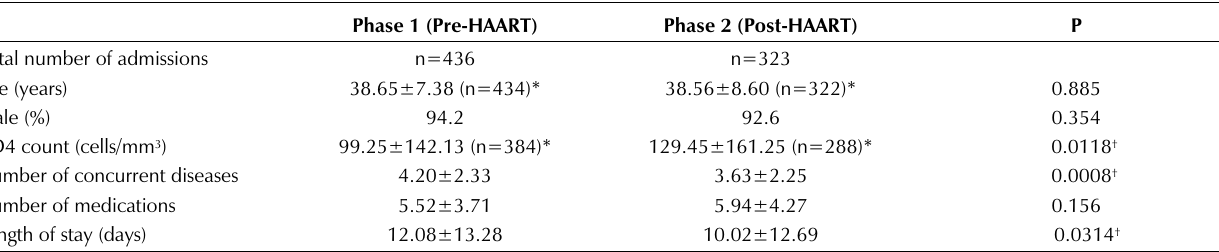
Phase 1 (Pre-HAART)